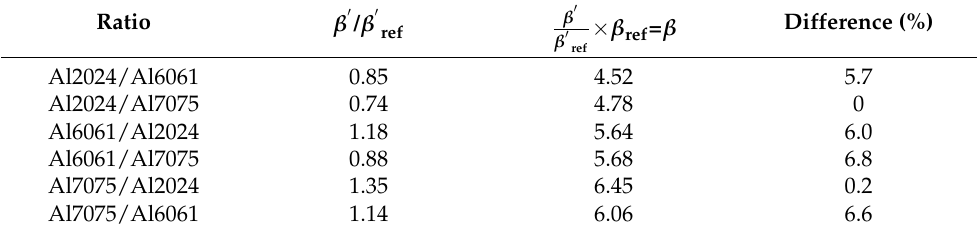
Table 6. Absolute nonlinear parameter obtained from the relative nonlinear parameter ratio of two